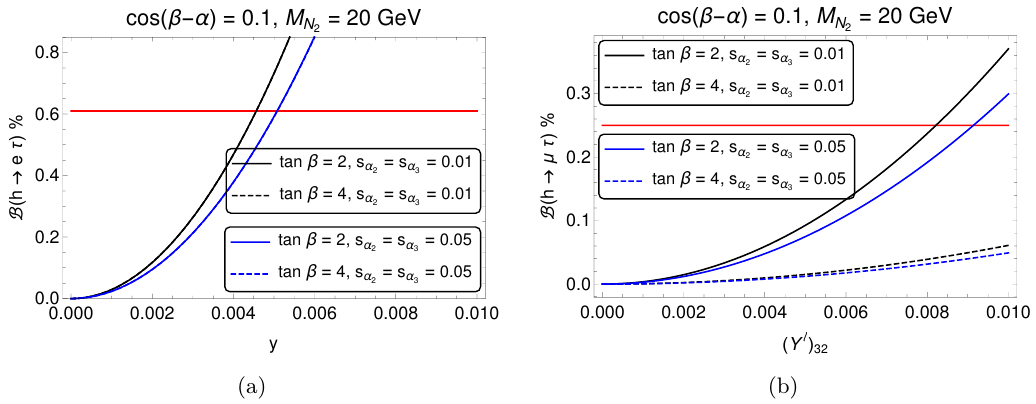
Figure 33 . (a) Variation of B ( h → eτ ) with off-diagonal Yukawa coupling y for two different values of tan β and other mixing angles. The red line denotes the upper limit on the branching ratio. (b) Similar variation for B ( h → µτ ) is